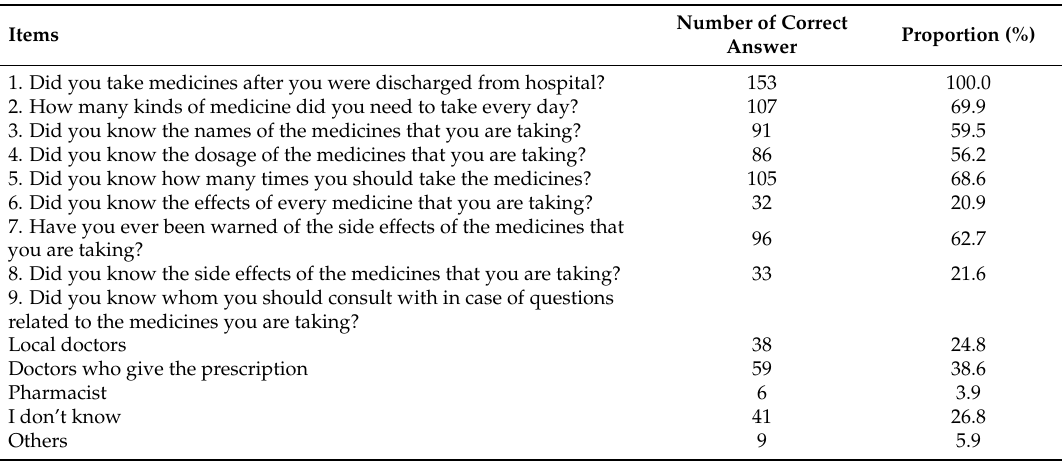
Table 1. Medication literacy for discharged patients with acute coronary syndrome (ACS), Changsha, Hunan, China, March to June 2015 ( n =